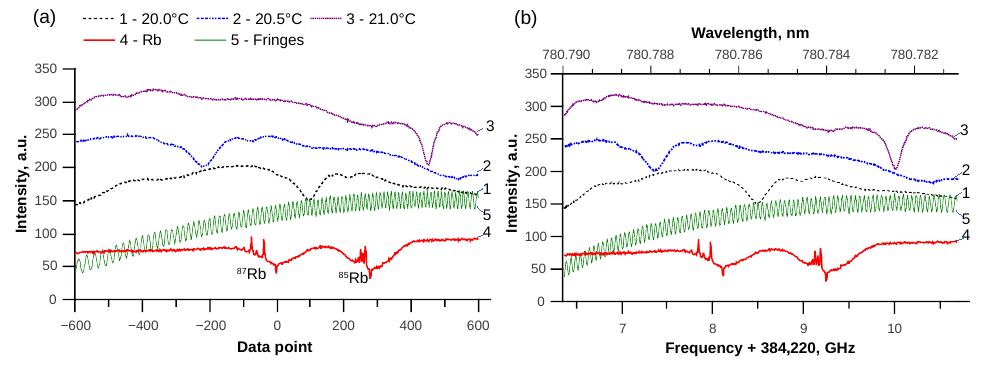
Figure 2. The temperature scanned WGMR resonance spectra for three different temperatures and two reference signals. ( a ) Before calibration, the laser scanning was obviously nonlinear, since at the beginning of the triangle signal the laser frequency scan was slower. ( b ) After calibration using both references for an almost linear absolute frequency